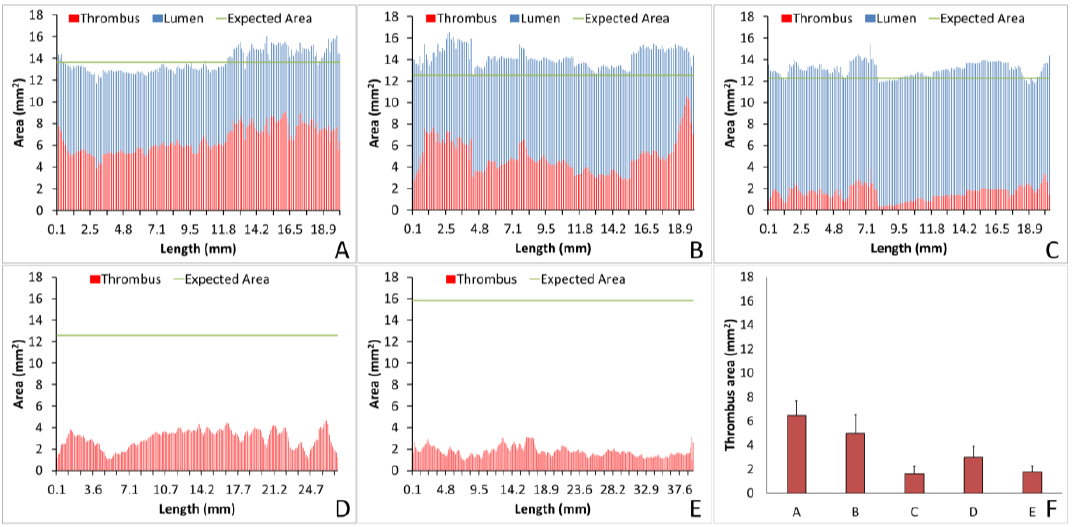
Figure 7. Quantification of the cross-sectional area per slice of the lumen or thrombus for single, representative samples, including a collagen-coated ePTFE sample without anti-coagulant ( A ), collagen-coated ePTFE with acetylsalicylic acid (ASA) alone ( B ), collagen-coated ePTFE with ASA and clopidigrel ( C ), ePTFE ( D ), and PVA ( E ). Horizontal lines in ( A – E ) labeled “Expected Area” are based on a caliper-measured diameter and represent a single point measurement. The average ± SD of thrombus area for all the slices is shown in samples ( A – E ) ( F ).